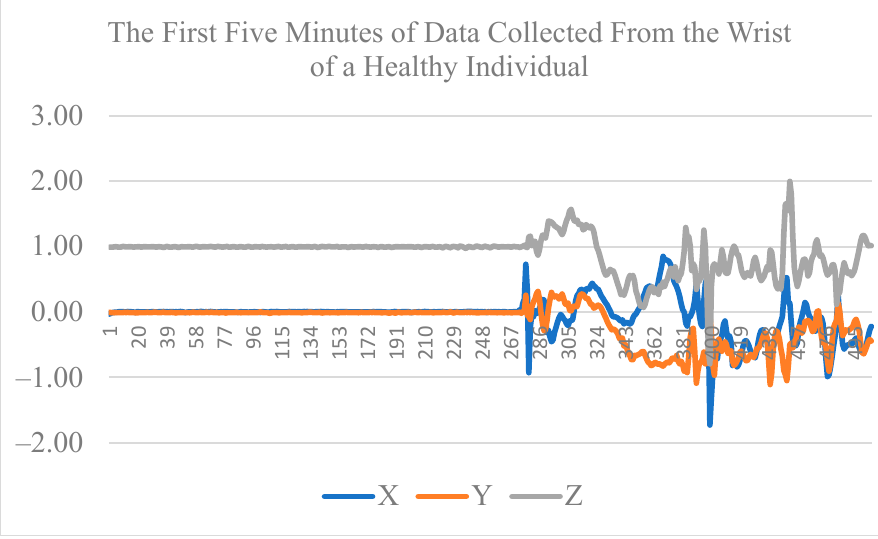
Figure 4. First five minutes of raw data collected from the wrist of a healthy individual.